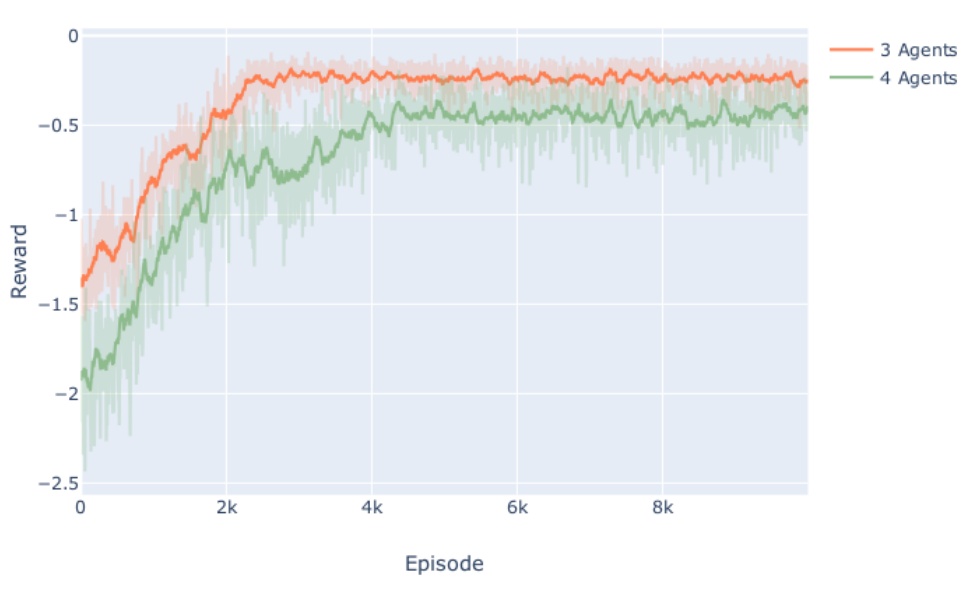
Figure 1. Evolution of cumulative reward per